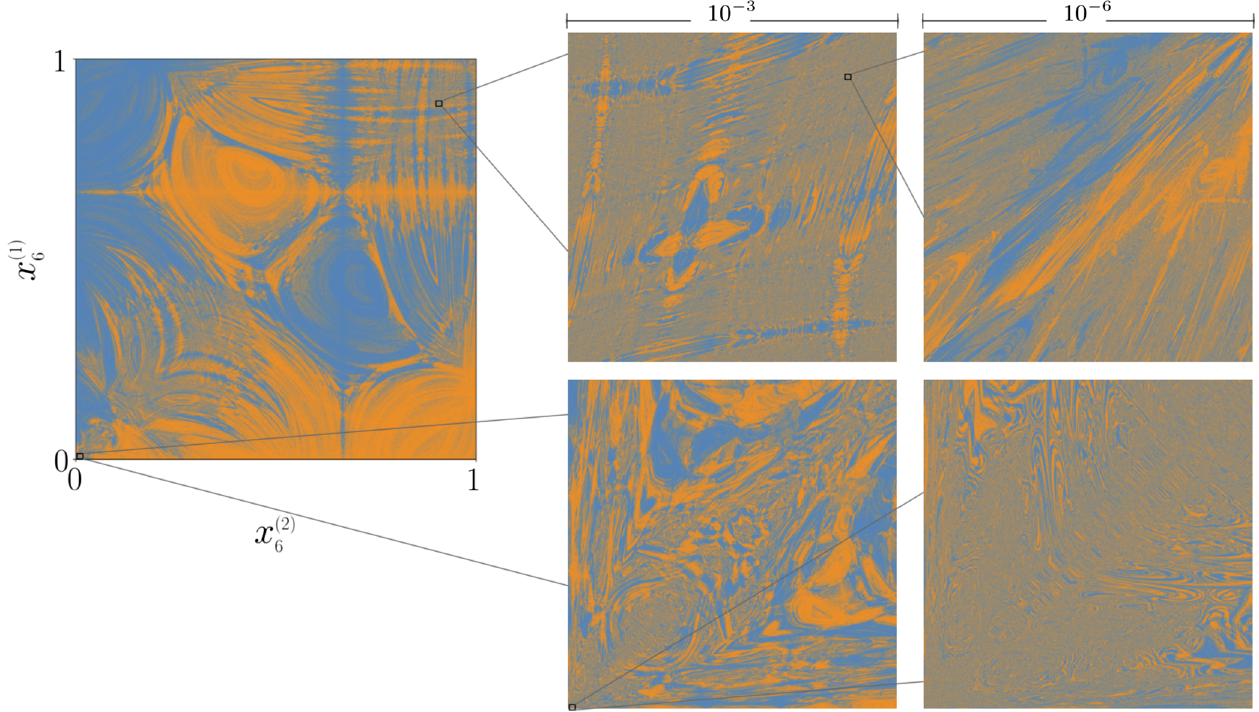
FIG. 7. Two-dimensional section of the state space showing intermingled basins of the two subchimeras. The two basins, shown in blue and orange, are fat fractals [85] intermingled with each other everywhere. Orange points are attracted to the subchimera where the first ring is synchronized, and the blue ones converge to the subchimera with the second ring synchronized. There is a symmetry between the two basins with respect to reflections across the diagonal, which originates from the reflection symmetry of the network. The areas marked for magnification are intentionally oversized to facilitate visualization. The choice of state-space section and system parameters are specified in the